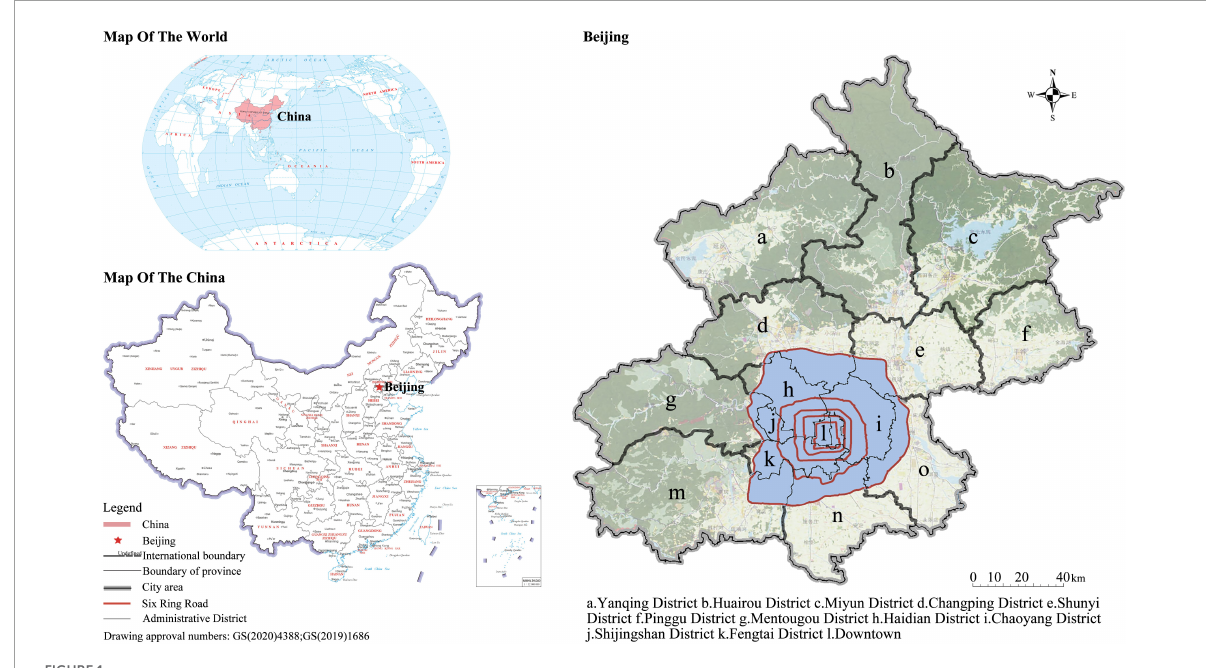
FIGURE1 Overview of study areas. The map is the official map approved by the China’s Ministry of Natural Resources and Beijing Municipal Planning Bureau.